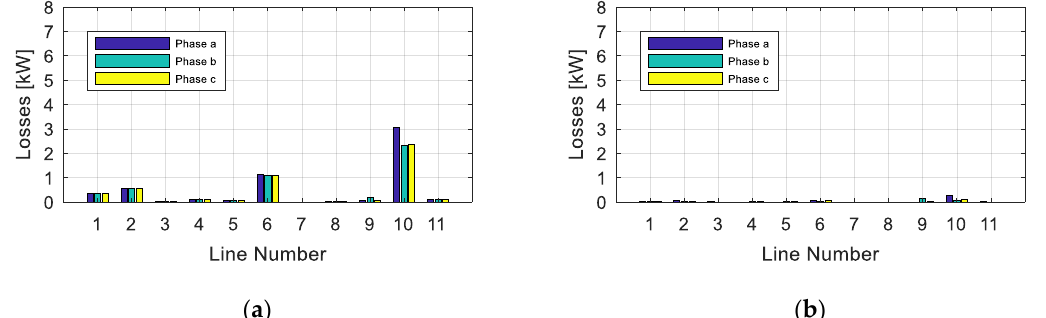
Figure 12 . Scenario 2: Line losses at the hours: ( a ) Peak-H and ( b ) Peak-L.